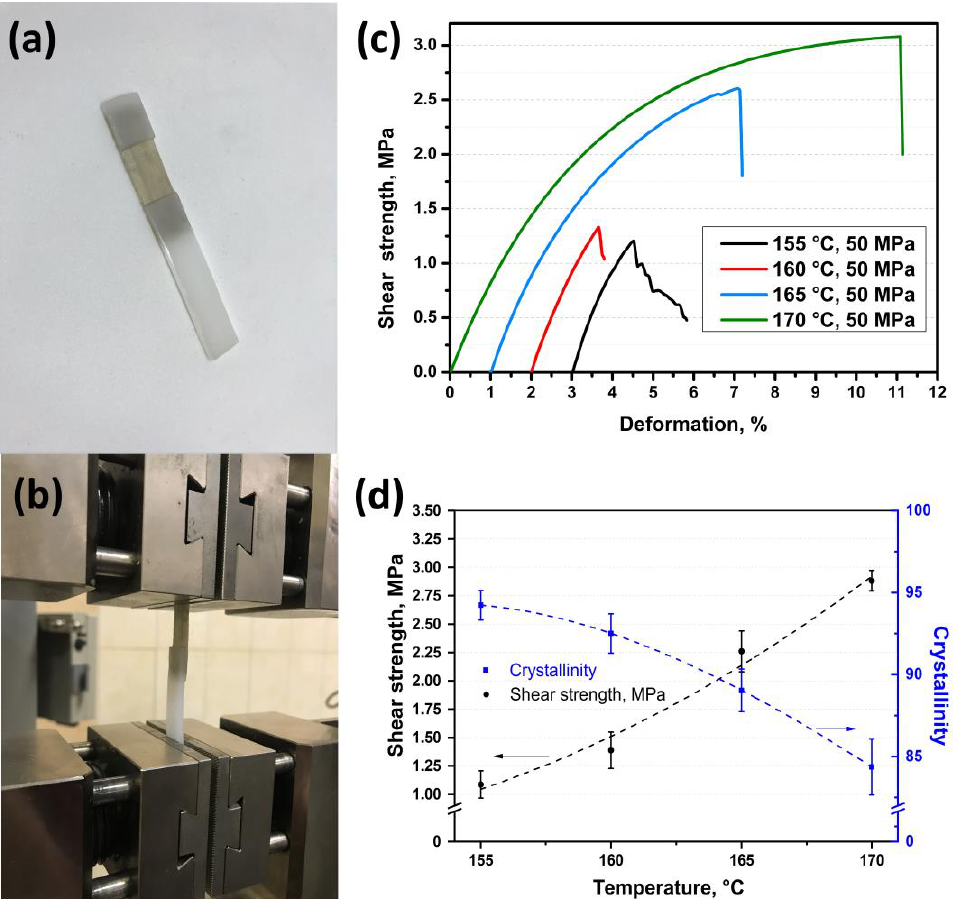
Figure 5. Photo of the samples ( a , b ), stress-strain curves ( c ) and shear strength ( d ) of the hybrid composites based on UHMWPE produced at 50 MPa and various temperatures. Table 1. Shear strength and crystallinity of the SRC obtained at different temperatures and pressures.